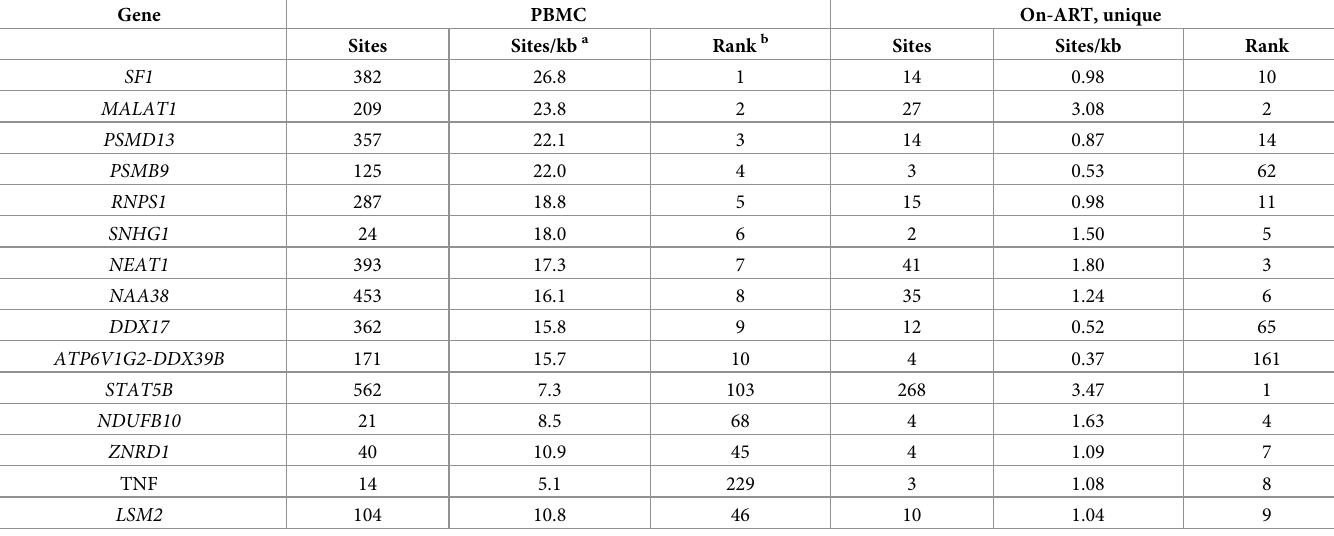
a Number of unique IS per gene in PBMC divided by its